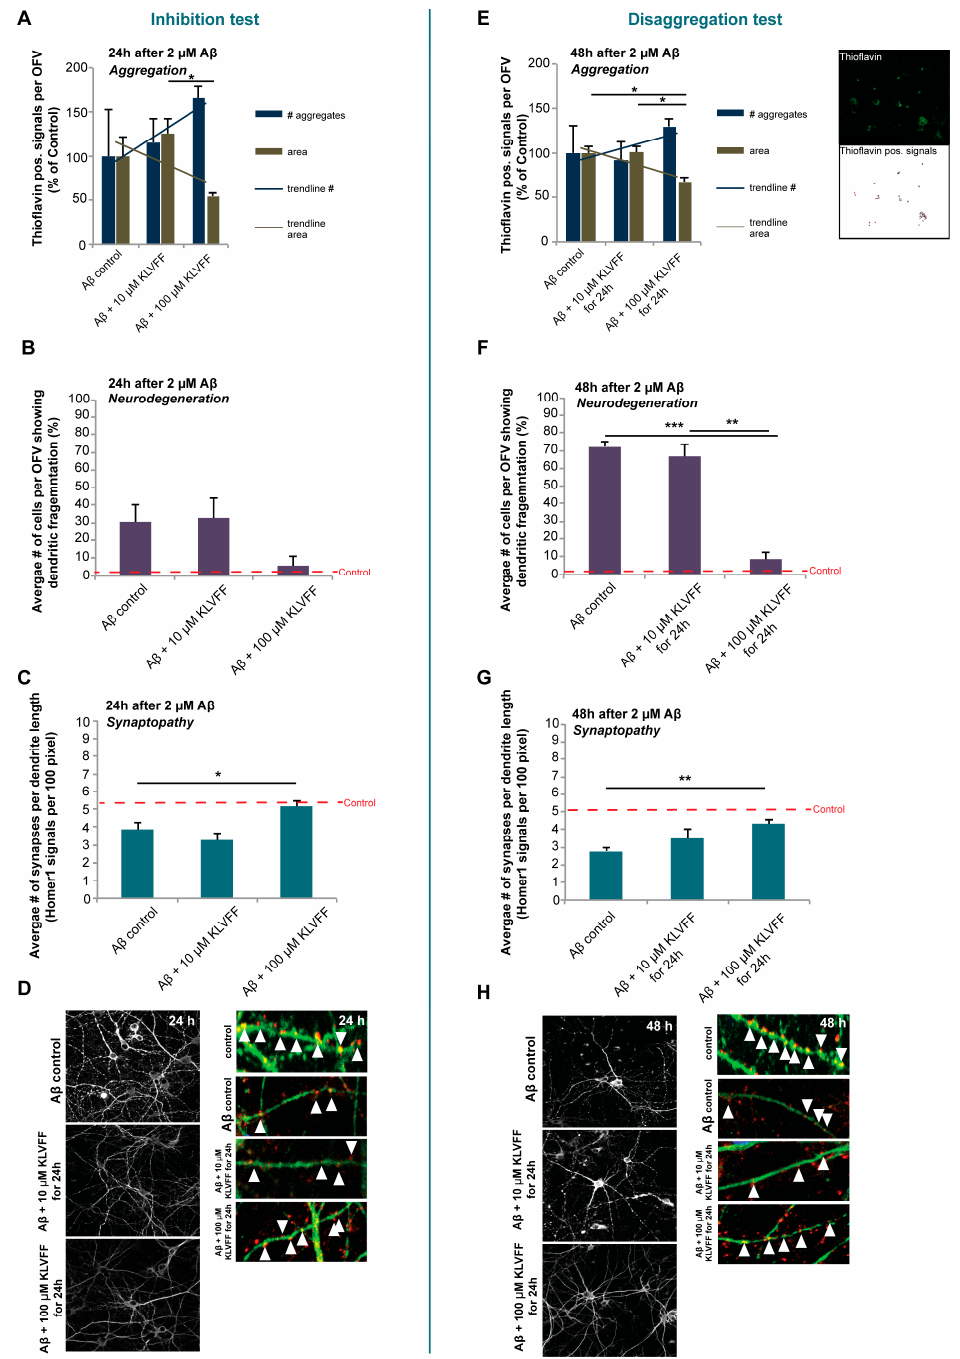
Figure 2. ( A , E ) The number and area (in pixel 2 ) of aggregates visualized by Thioflavin staining and measured in three optic fields of view (OFV). The results are shown in percentage of control. ( B , F ) The number of cells showing fragmented dendrites (microtubule-associated protein 2 (MAP2) staining) was analyzed. ( C , G ) A “synaptopathy” was evaluated by measuring the number of Homer1 positive signals per dendrite length. Three optic fields of view (OFV) with at least ten cells were evaluated. ( D ) Left panel: MAP2 staining showing dendritic fragmentation as an early sign of neurodegeneration. Right panel: MAP2 (green) and Homer1 (red) staining visualizing synapses along a dendrite. ( H ) Left panel: MAP2 staining showing dendritic fragmentation as an early sign of neurodegeneration. Right panel: MAP2 (green) and Homer1 (red) staining visualizing synapses along a dendrite. A more detailed caption with the relevant statistical analysis data is reported in the supplementary material.